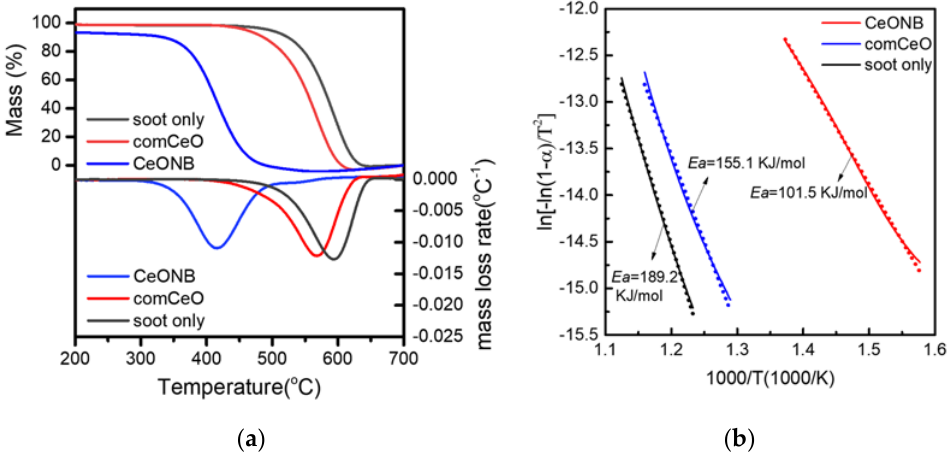
Figure 7. Soot oxidation by CeONB and comCeO: ( a ) soot conversion (%) under the loose contact